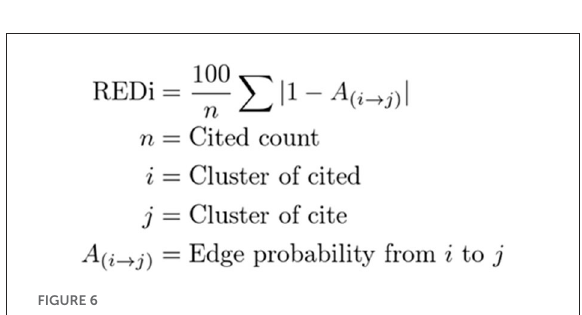
FIGURE6 Calculation of the score of the diversity index.